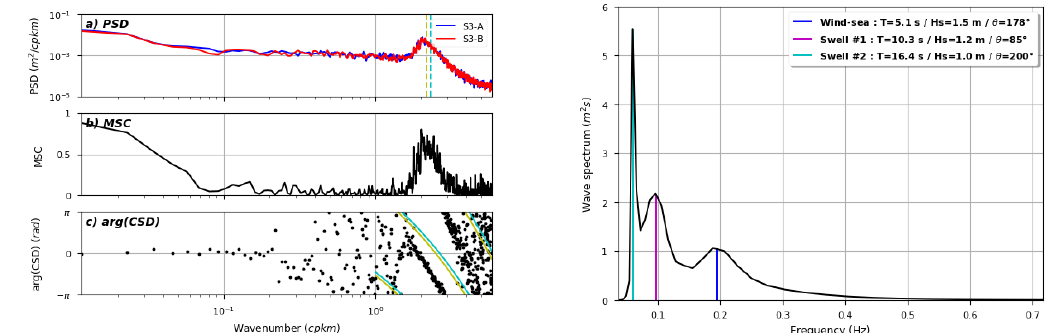
Figure 11. Left : Spectral analysis of 80-Hz sea-level anomaly showing an energy bump in the power spectral density (PSD), high magnitude squared coherence (MSC) value, and decreasing phase shift around the swell wavelength. Right : WAVEWATCHIII wave spectrum showing strong swell partition with 16.4 s period and 200° angle wrt track. Reprinted from [16].